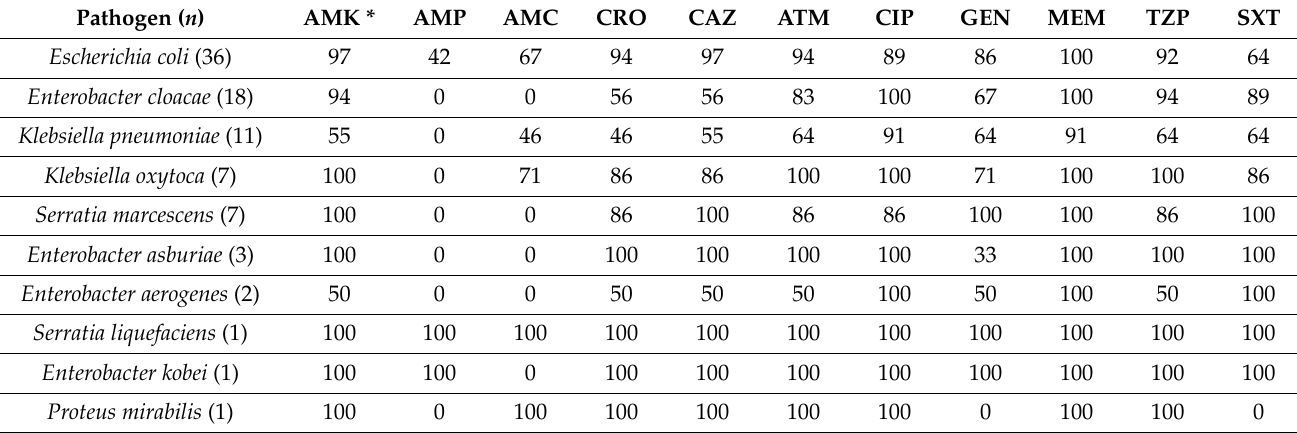
Table 3. Percentages of susceptibility for the isolated pathogens.